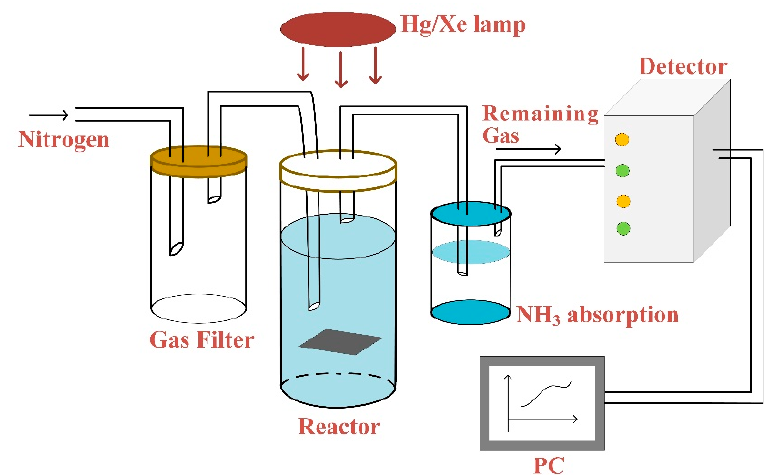
Figure 1. Schematic diagram of simple reaction vessel (Gas filter guarantees purity of reaction gas N 2 without impurities. Then, N 2 was slowly bubbled into vessel contained 18.2 M Ω water (Barnsted NanoPure) with 0.01 M high-purity (Alfa Puratronic, 99.9955%) Na 2 SO 4 . The container was sealed by quartz cover and exposed to light for different time periods. The gas exported from vessel was run through the NH 3 absorption bottle and finally exported from the computer system).